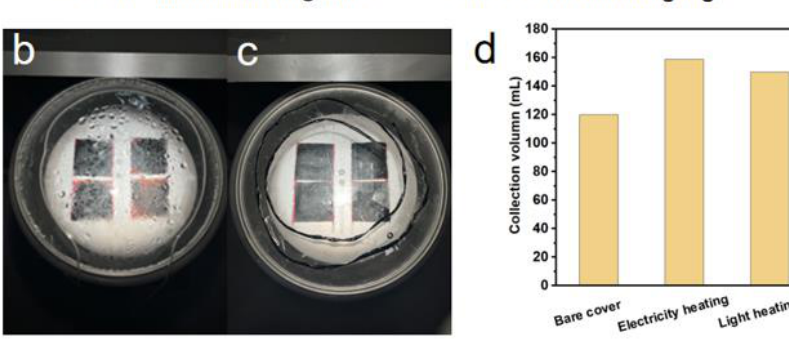
Figure 8. Scheme and solar vapor collection performance of top cover heating: ( a ) bare cover with optical loss and heating wire on the cover with high light transmission. Photos of corresponding heating wires: ( b ) active (electricity) heating wire and ( c ) passive (light) heating wire. ( d ) Collection performance of different cover heating ways.